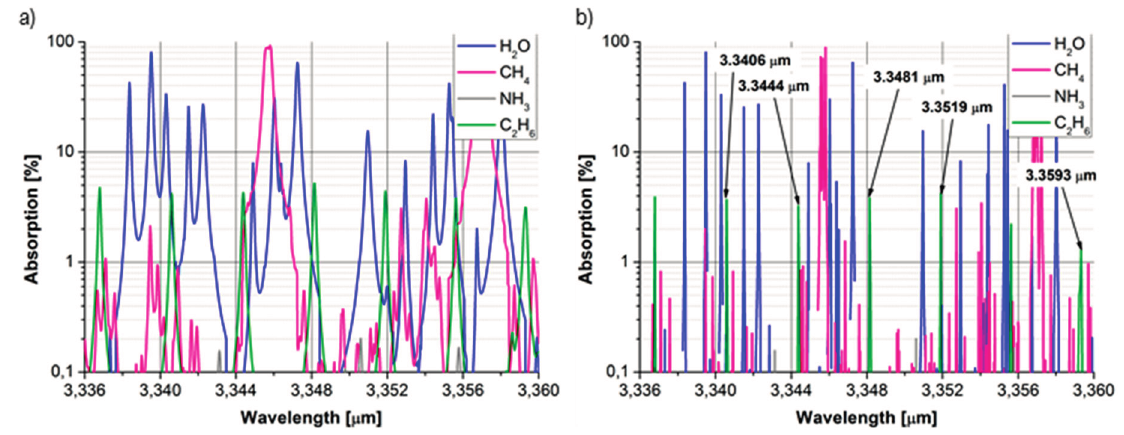
Figure 3. ( a ) The absorption of C 2 H 6 at pressures of 1 atm ( b ) and of 0.1 atm for concentrations occurring in human breath: C 2 H 6 —10 ppb, NH 3 —2 ppm, CH 4 —1.7 ppm, H 2 O after the drying procedure—279 ppm.